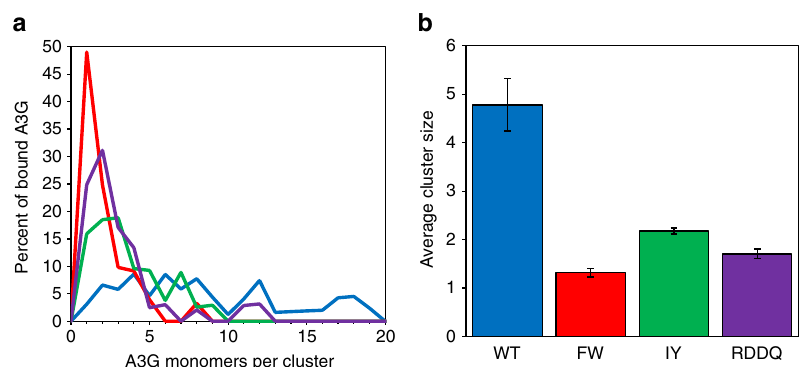
Fig. 1 Measurements of A3G oligomerization using AFM imaging. a The number of monomers per A3G cluster formed on ssDNA are plotted in a histogram. FW A3G (NTD mutant) is mostly bound to the ssDNA in a monomeric form. For IY and RDDQ A3G (CTD mutants) the most common state is a dimer. WT A3G is more likely to form tetramers and larger oligomers as compared to the mutants. b Comparison of average cluster size for WT and mutant A3G. Mutating the CTD moderately reduces oligomerization whereas mutating the NTD disrupts oligomerization to an even greater degree. Error bars are SE based on the size of individual protein clusters formed on at least seven DNA constructs per A3G variant